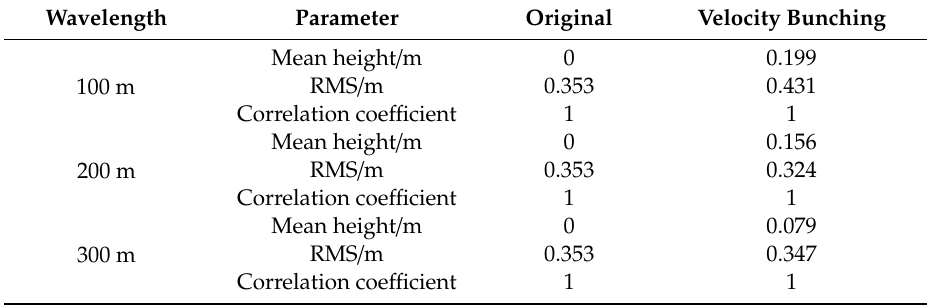
Table 4. The influence of velocity bunching under different swell wavelength (the propagation direction is 90°, the SWH is 2 m).